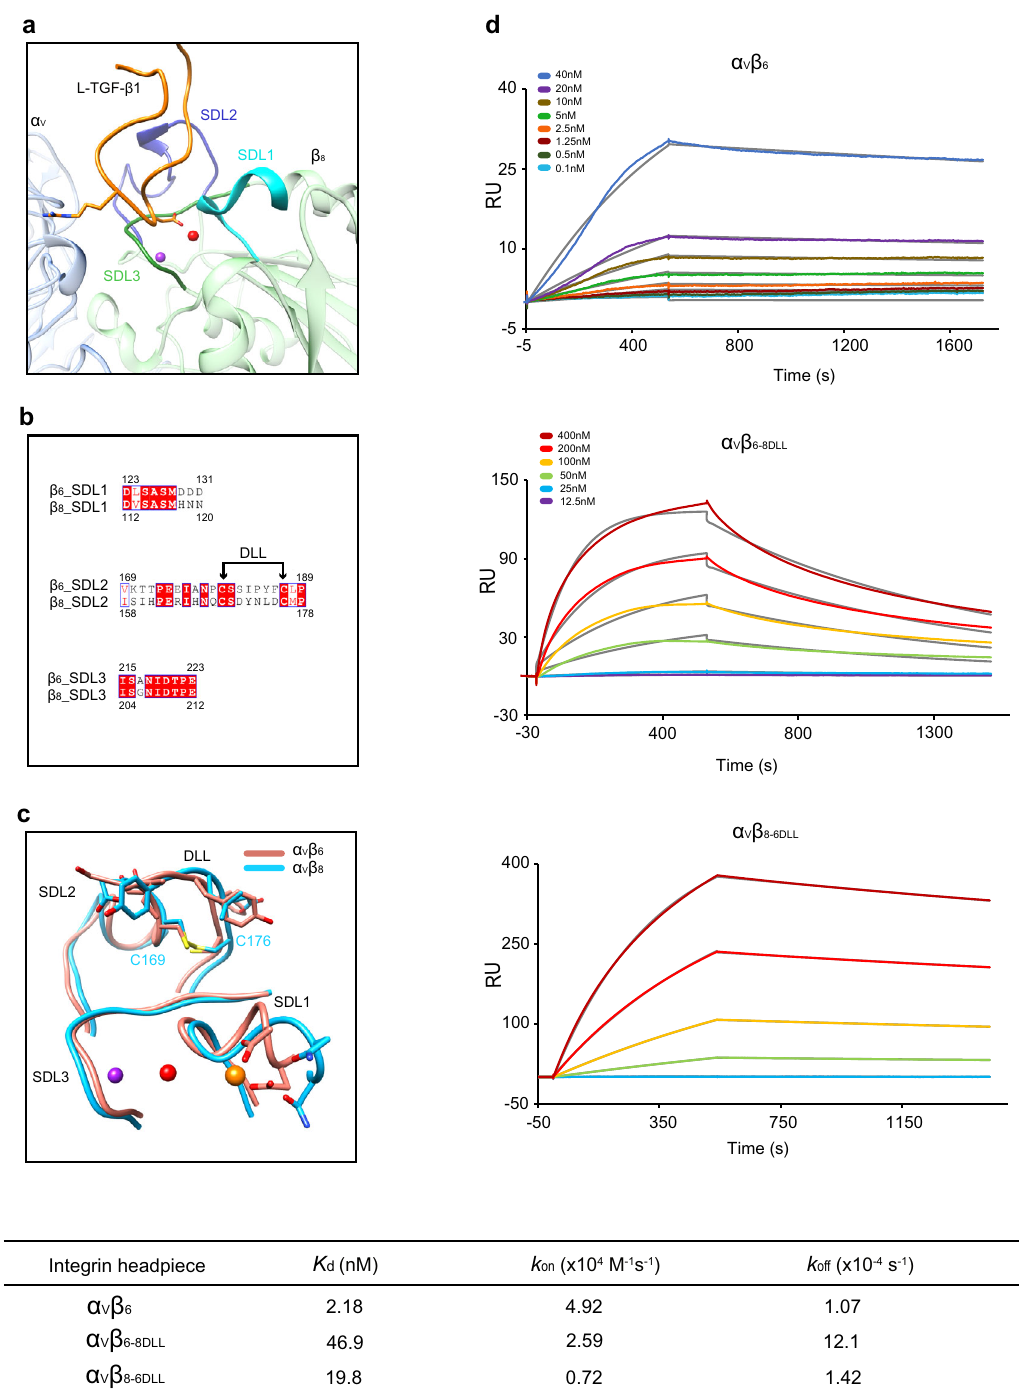
Fig. 5 | Structural and functional analyses of the disul fi de-linked loop (DLL) regions of integrin subunits β 6 and β 8 for their contributions to L-TGF- β 1 binding. a Ribbon diagram for the speci fi city-determining loops (SDLs) of α V β 8 in the complex structure with L-TGF- β 1. SDL1, cyan; SDL2, purple; SDL3, dark green. b Sequencealignment of the three SDLs between integrin subunits β 6 and β 8 . DLL, disul fi de-linked loop. c Structural comparison of SDLs in the structures of α V β 8 /L- TGF- β 1 (blue) and α V β 6 /L-TGF- β 1 (pink, PDB code: 5FFO). d The surface plasmon